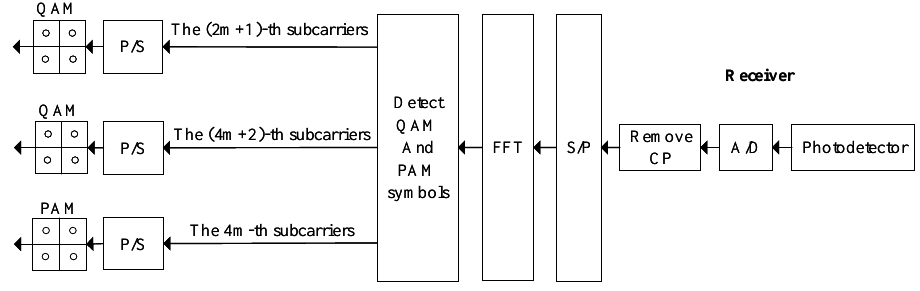
Figure 2. Block diagram structure of the receiver of the proposed HABO-OFDM